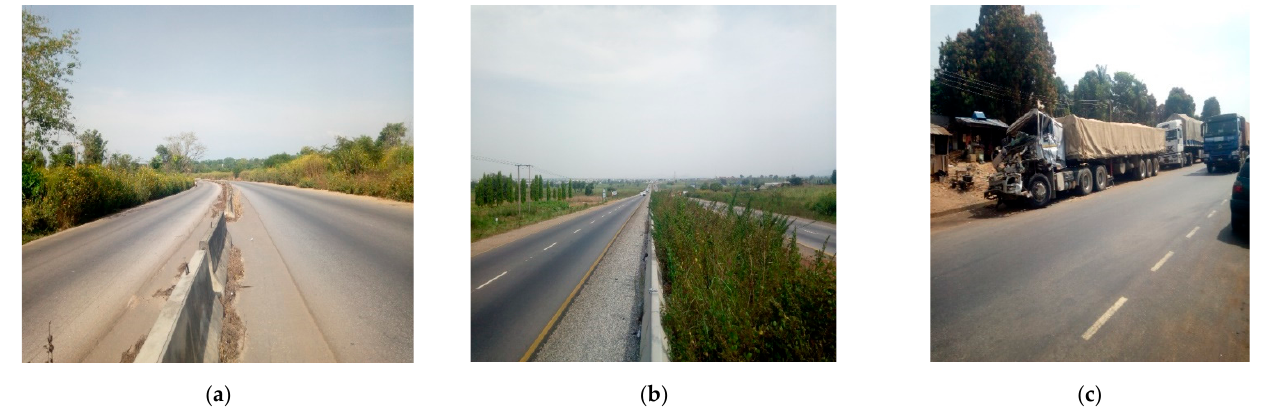
Figure 7. Hotspot locations along the study sections. ( a ) Sharp horizontal curve at Agena; ( b ) Vertical curve at Achi area; ( c ) Trucks parking on deceleration lane at Sabon Gida.